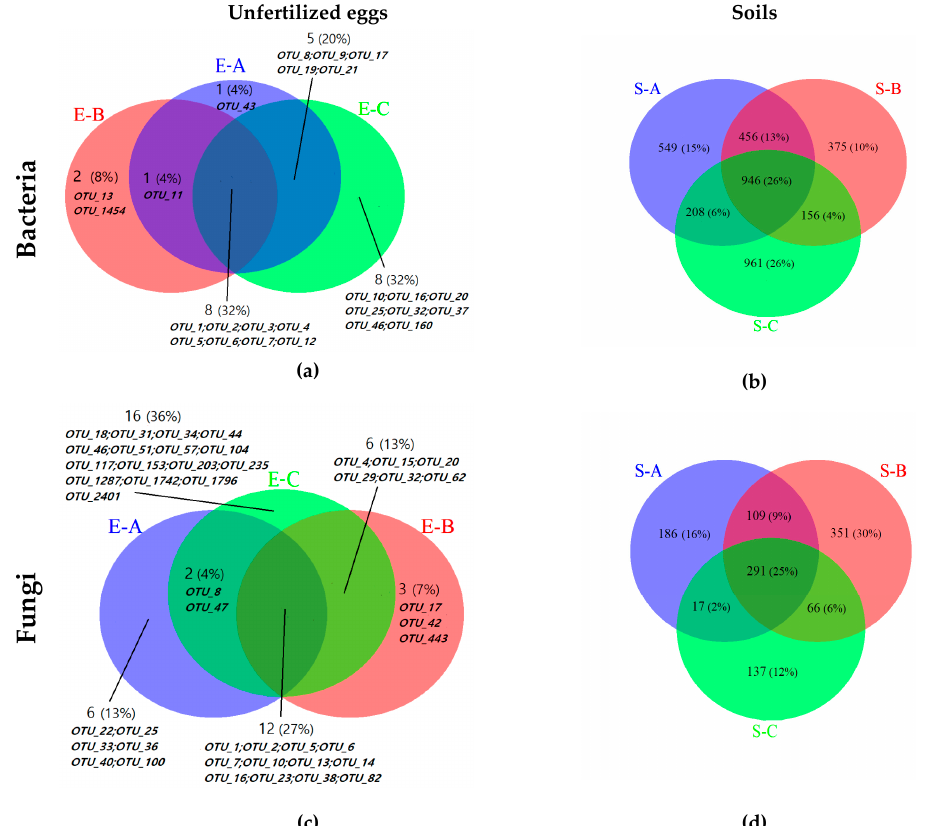
Figure 2. Venn diagrams depicting the unique and shared operational taxonomic units (OTUs) among the samples from di ff erent sampling sites. ( a , b ) for bacterial community in unfertilized eggs and soil samples, respectively. ( c , d ) for fungal community in unfertilized eggs and soil samples, respectively. A, B, and C in each diagram present di ff erent sampling sites with high, low, and null Chinese cordyceps, respectively. S-A, S-B, and S-C represent the soil samples from sites A, B and C, respectively; E-A, E-B, and E-C represent the unfertilized eggs samples from sites A, B and C, respectively. The OTUs for each site selected for generating the Venn diagrams were the shared OTUs among all of the samples within each group (e.g., for bacterial OTUs in E-B, 11 OTUs in total were shared among E-B1, E-B2, E-B3, E-B4, and E-B5, and these 11 OTUs were selected to generate the Venn diagram). For unfertilized eggs samples, bacterial OTU_1 ( Wolbachia ), OTU_2 (Firmicutes), OTU_3 (Gammaproteobacteria), OTU_4 ( Spiroplasma ), OTU_5 ( Carnobacterium ), OTU_6 ( Acinetobacter ), OTU_7 ( Sphingobium ), and OTU_12 ( Cupriavidus ) are shared among all of the egg samples; fungal OTU_1 (Basidiomycota), OTU_2 (Basidiomycota), OTU_5 ( Aureobasidium ), OTU_6 (Sordariomycetes), OTU_7 (Fungi), OTU_10 (Fungi), OTU_13 (Fungi), OTU_14 ( Phoma ), OTU_16 (Fungi), OTU_23 (Basidiomycota), OTU_38 (Agaricomycetes), OTU_82 ( Davidiella ) are shared among all of the egg samples. The detailed taxonomic information of the OTUs were supplemented in Tables